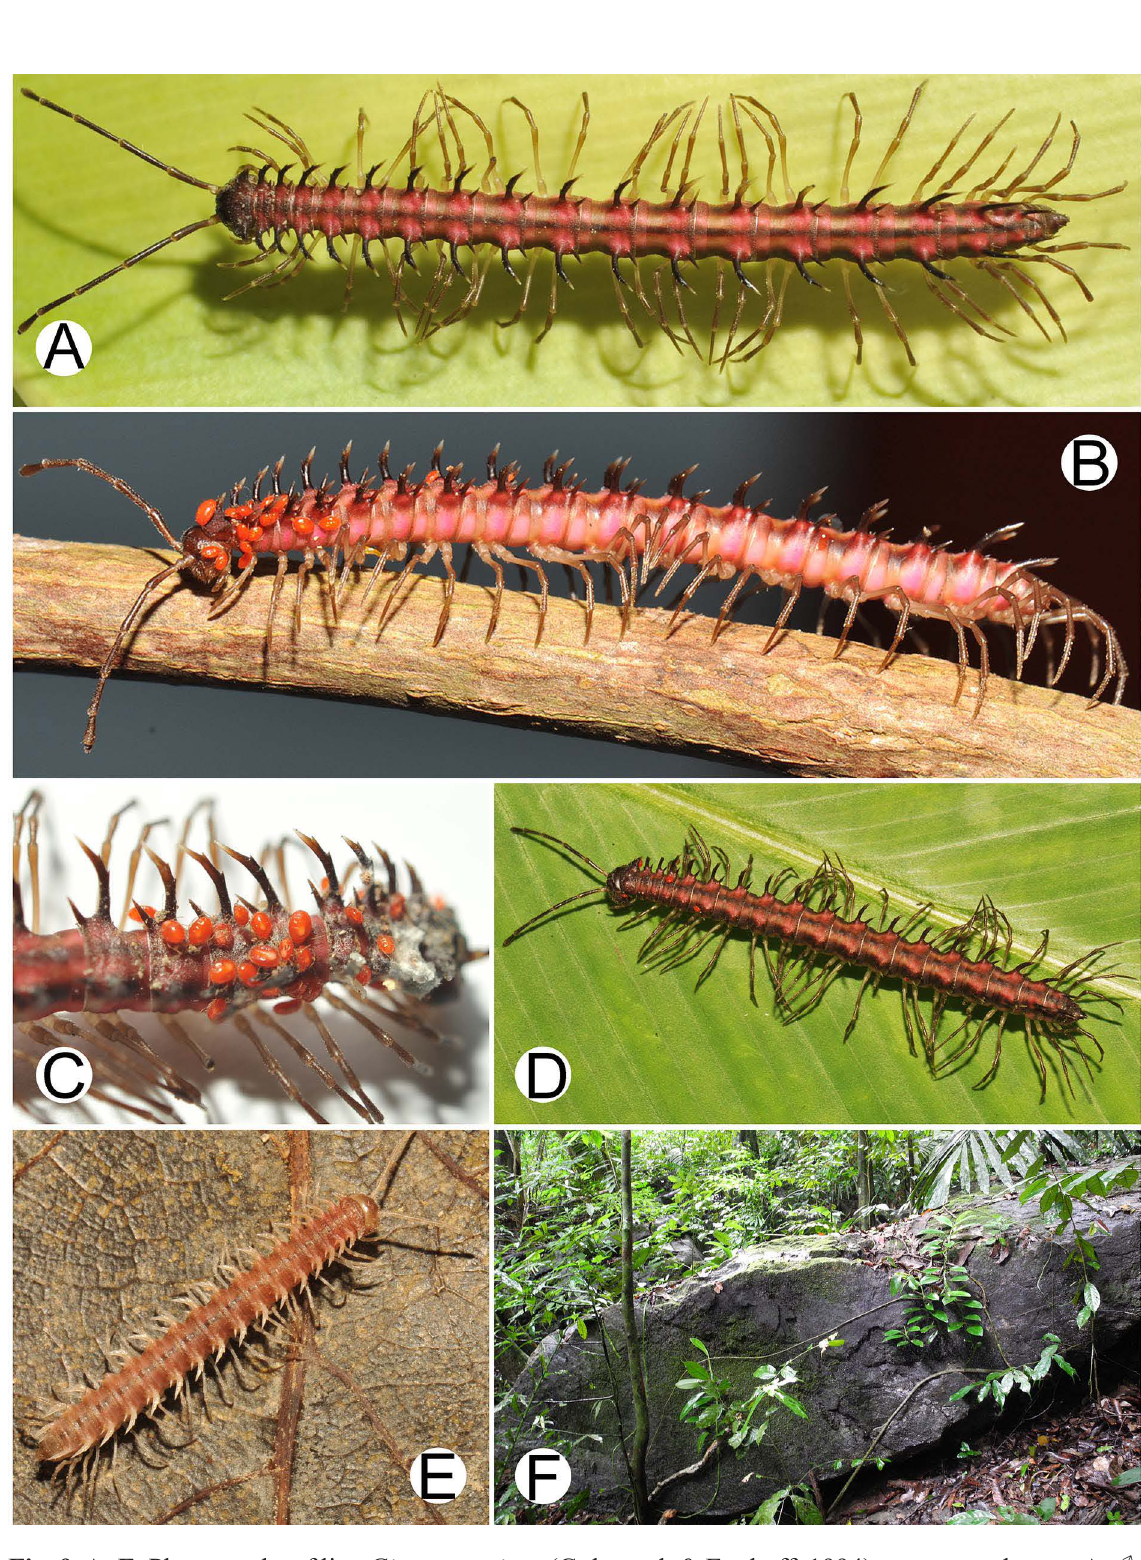
Fig. 9. A – E . Photographs of live Gigaxytes gigas (Golovatch & Enghoff, 1994) gen. et comb. nov. A . ♂ , specimen from Wat Tham Sue (Tiger Cave). B . ♂ , specimen from Wat Tham Phra Phut. C . Parasitic ? Leptus mites on ♂ . D . ♀ , specimen from Wat Tham Sue (Tiger Cave). E . Juvenile. F .